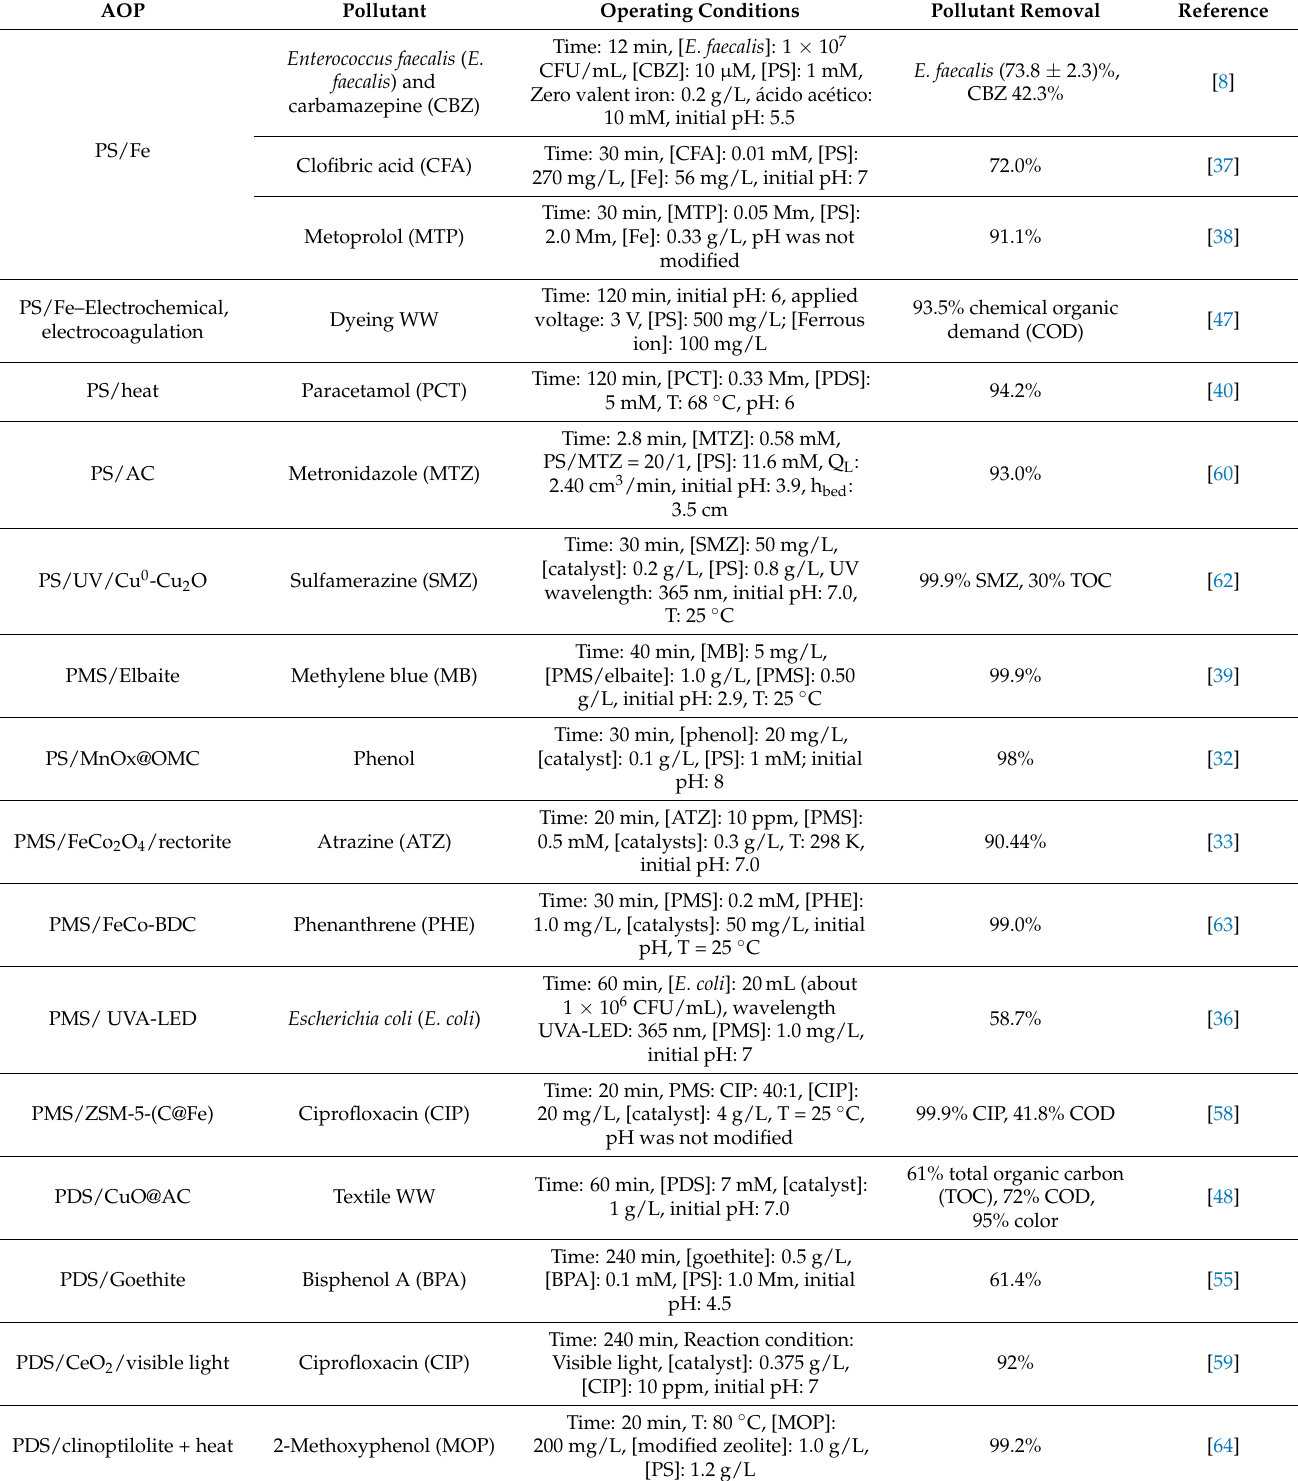
Table 1. Advanced oxidation processes (AOPs) based on sulfate radicals (SO 4 • −